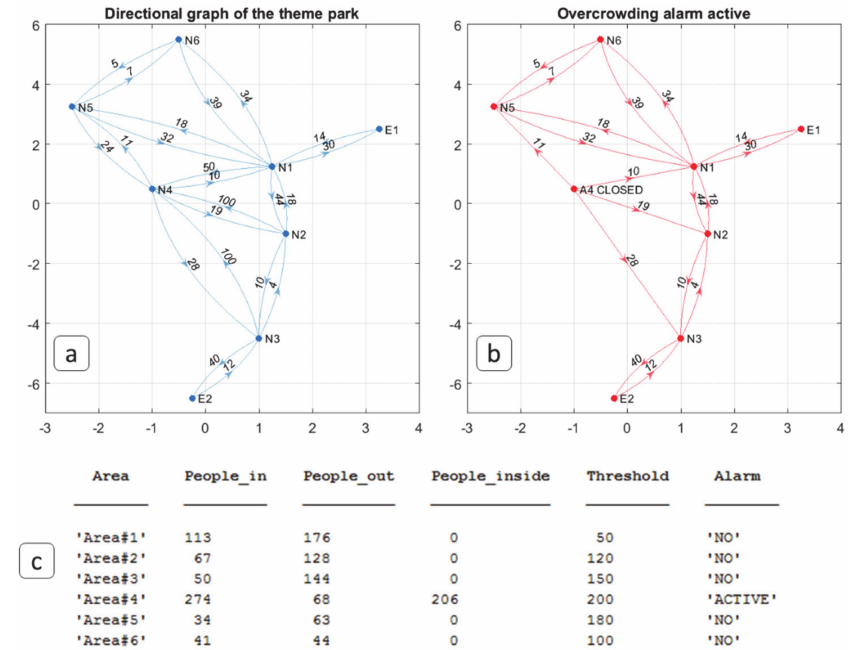
Figure 11. Example of the results of the Algorithm 3 in case of an overcrowding alarm at node 4, where ( a ) is the graph without an alarm, ( b ) is the graph in case of an alarm, and ( c ) is a table showing the overall condition.